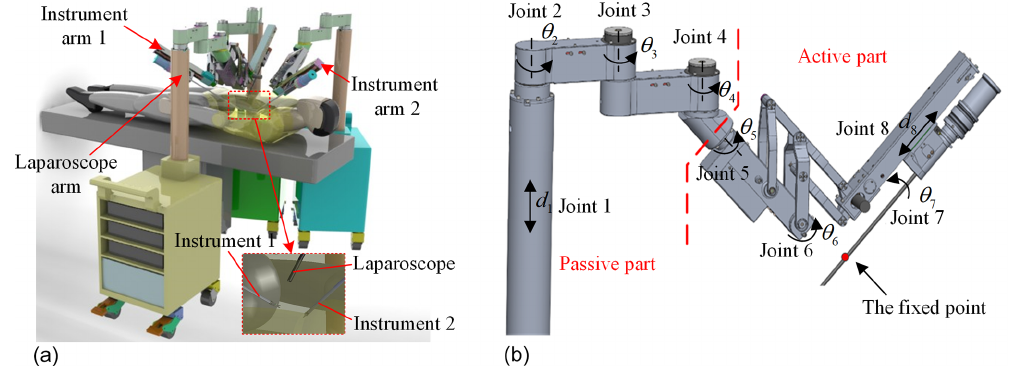
Figure 1. The MIS robotic system and its robotic arm structure. (a) Celiac minimally invasive robot-assisted surgery system. (b) The structure of the surgical robotic arm.